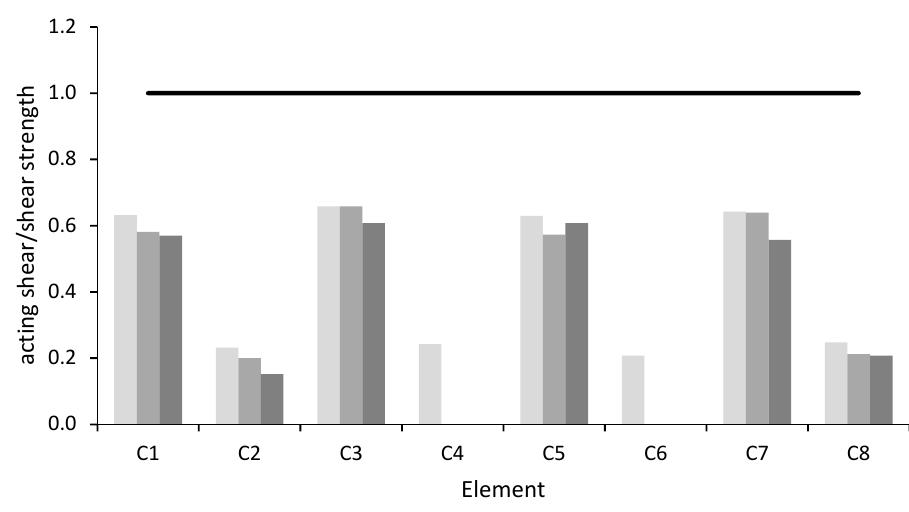
Figure 23. Columns’ shear verifications, after retrofit.